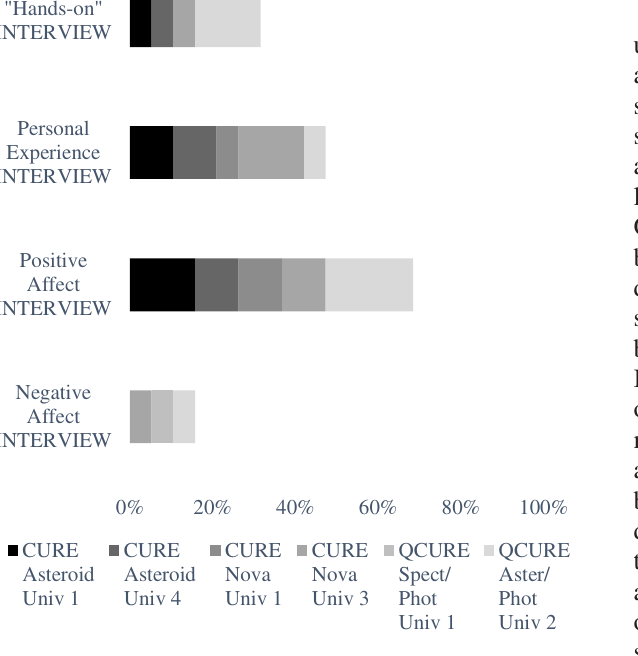
FIG. 7. Percentage of responses represented within each theme regarding the category of engagement. Themes were generated from qualitative analyses of students ’ interview responses ( n ¼ 19 ) characterizing RBSEU instruction compared to pre- vious instruction, shaded by course type.